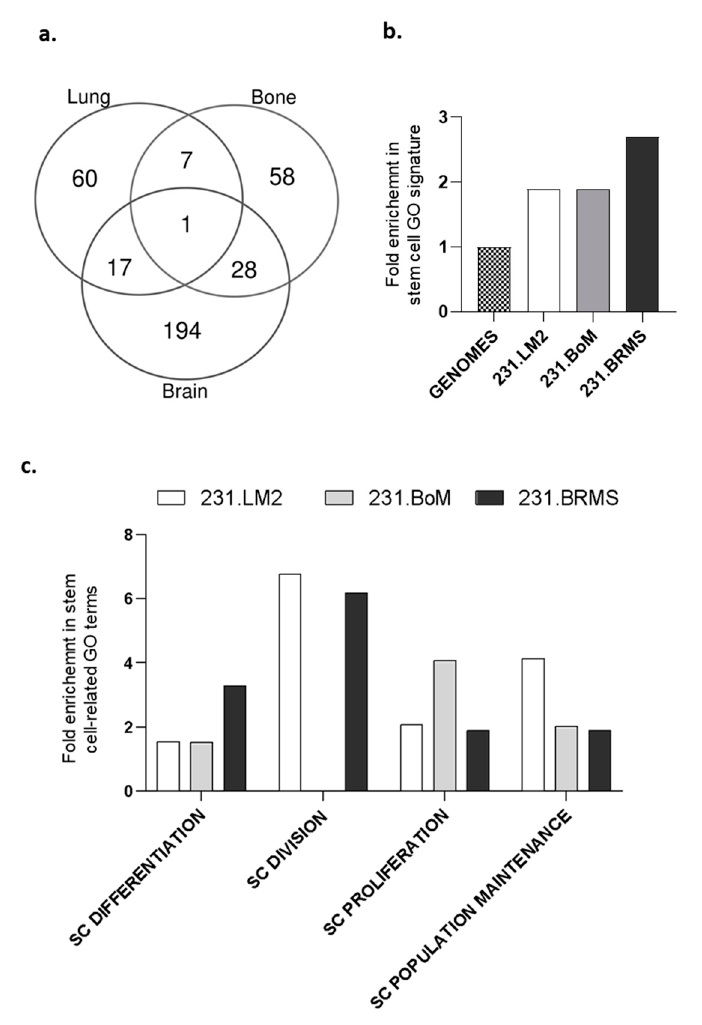
Figure 1. Organotropic breast cancer cell lines show an enriched stem cell-like signature. Enrichment analysis for stem cell gene ontology terms using the significantly deregulated gene (DEG) list between each organotropic breast cancer cell line and the parental MDA-MB-231 cell line. ( a ) Venn diagram showing the common and specific DEGs between the different organotropic variants. ( b ) Overall enrichment in stem cells gene ontology (GO) signature and ( c ) in stem cell-related GO terms after an analysis of the specific DEGs annotated with a stem cell function. SC: stem cell.